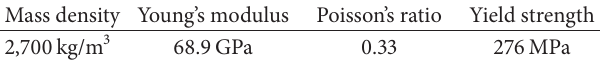
Table 1: Material properties for Al 6061-T6